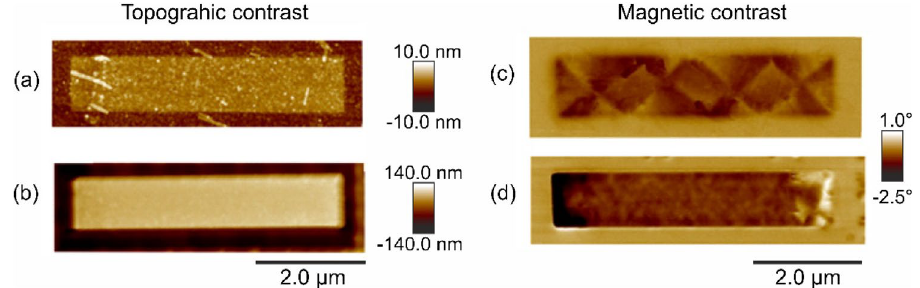
Figure 2. (Color online) Atomic force microscopy images ( a ) of the region irradiated with a highly focused Ne + -ion beam at 25 keV and a fluence of 10 ions/cm 2 thereby forming disordered A2 Fe 60 Al 40 embedded within a B2 Fe 60 Al 40 surrounding. ( b ) The same region as in ( a ) after milling away the B2 Fe 60 Al 40 surrounding. ( c , d ) Magnetic force microscopy images showing the magnetic phase contrast corresponding to the topographic contrast in ( a ) and ( b ),